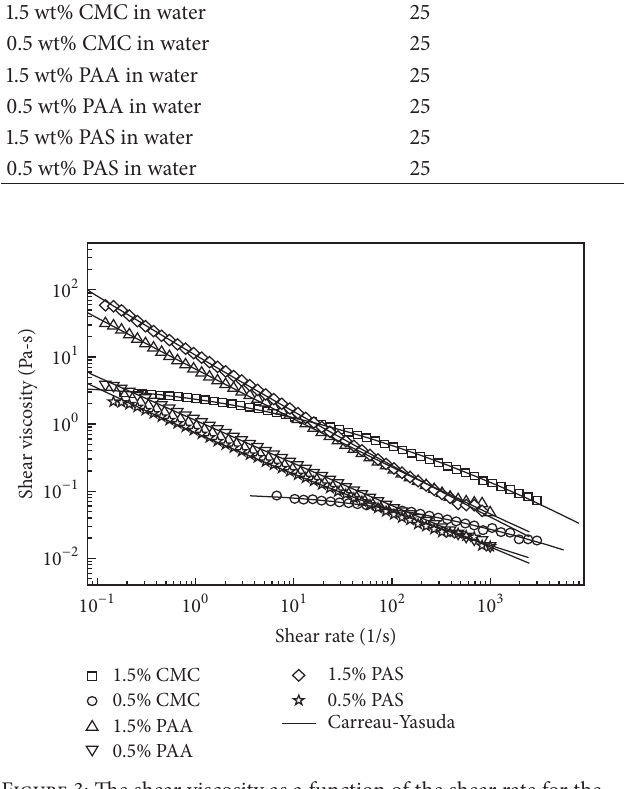
Figure 3: The shear viscosity as a function of the shear rate for the studied solutions and Carreau-Yasuda model fitted curves.